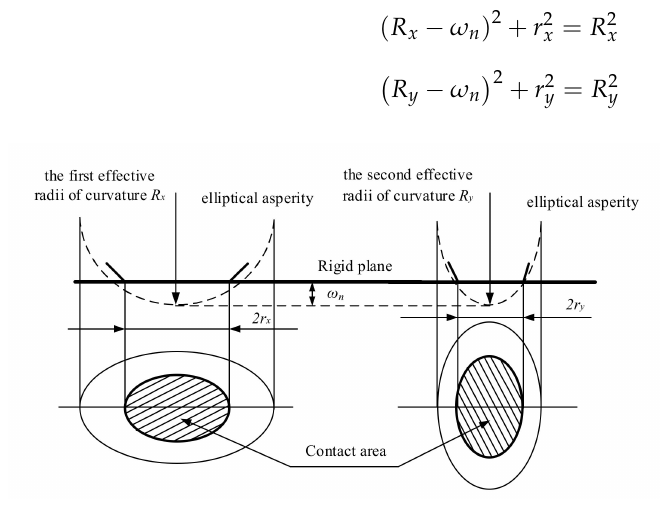
Figure 4. The geometric model of a single elliptical